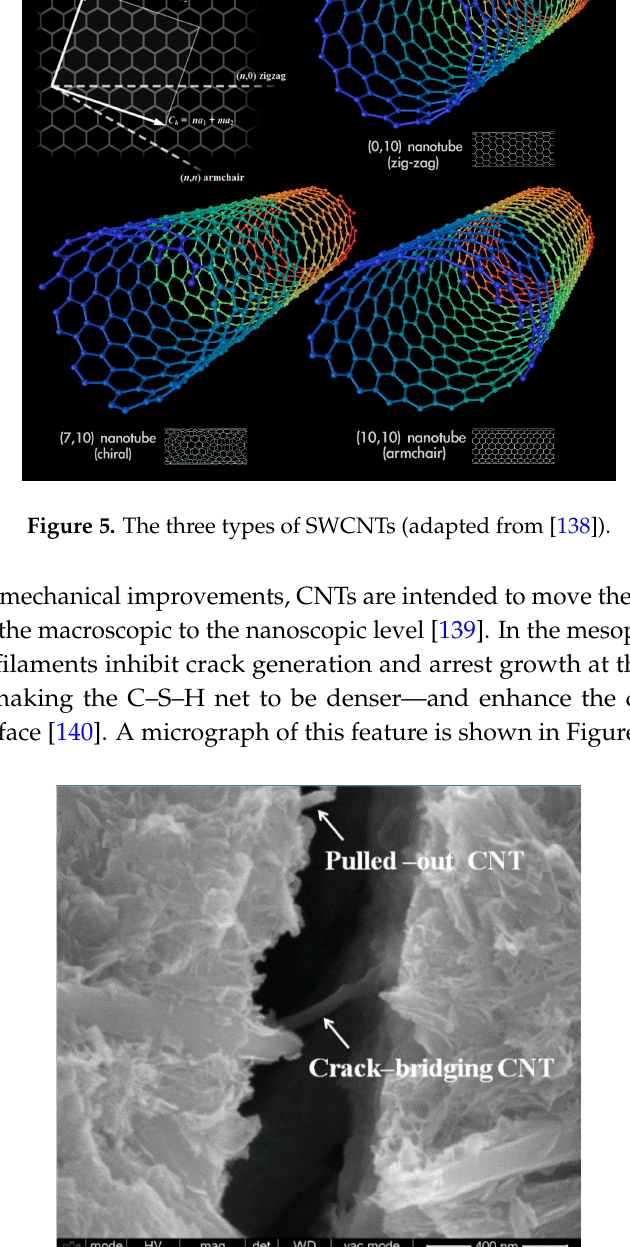
Figure 6. Crack bridging with MWCNTs (adapted from [141]).